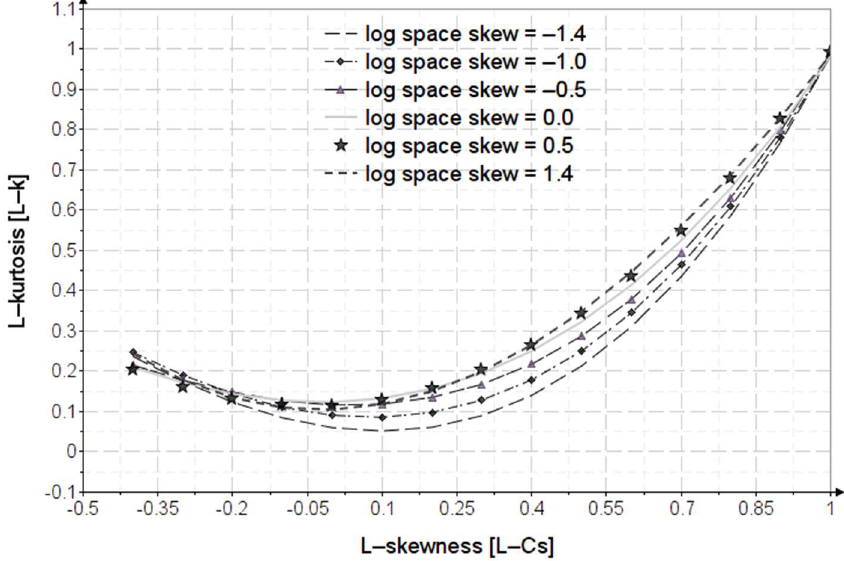
Figure 16. The variation of the L-kurtosis–L-skewness, for LogPearson. The graphs between τ 3 and τ 4 also represent a criterion for choosing the best distri- butions to use in achieving a regionalization based on L-moments [5,17].